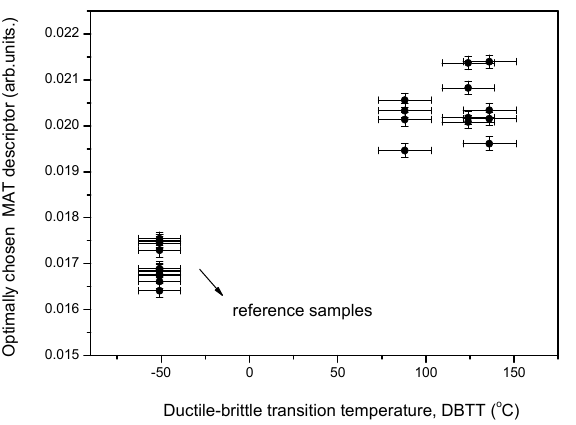
Figure 3. Optimally chosen MAT descriptors as a function of the transition temperature for the material 15Kh2NMFA.